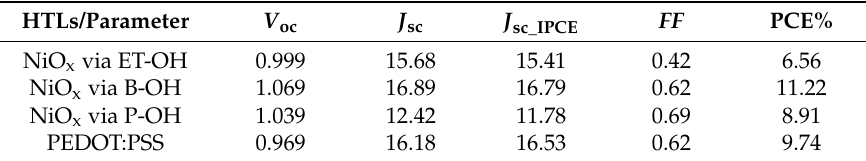
Table 1. Performance parameters of the planar inverted PSC devices.